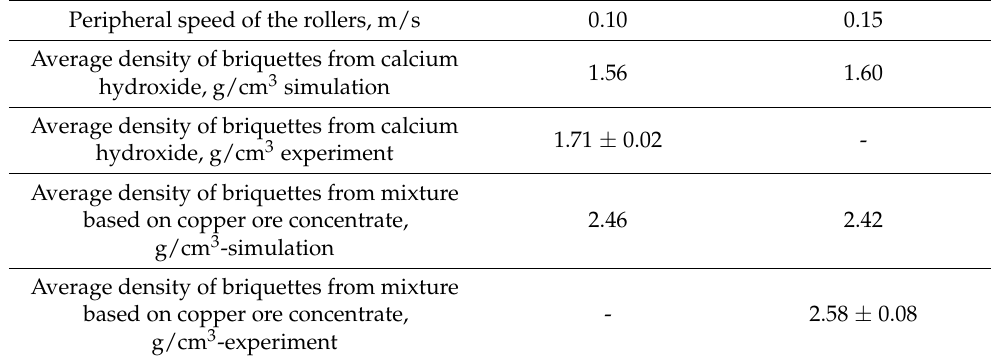
Table 5. Comparison of the average density of briquettes obtained in simulation and laboratory tests.